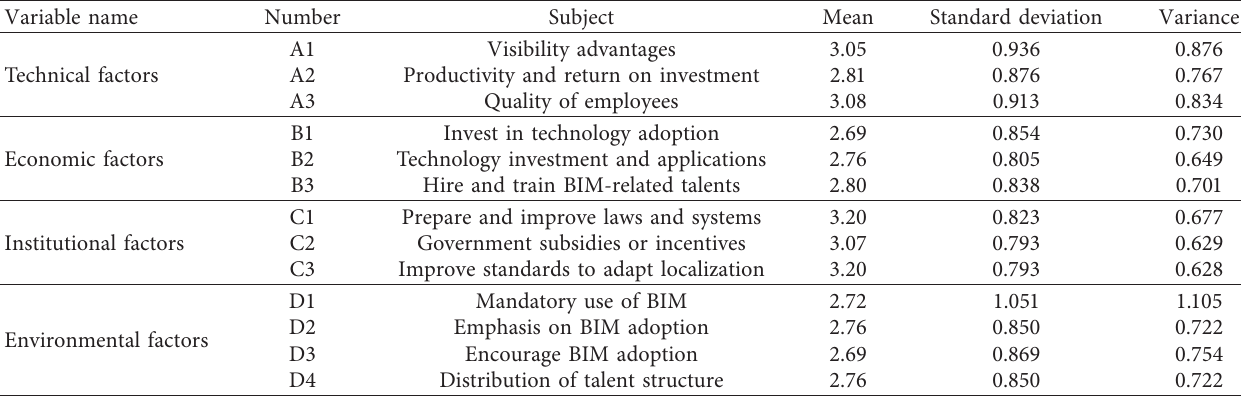
Table 3: Descriptive statistical analysis of sample data.